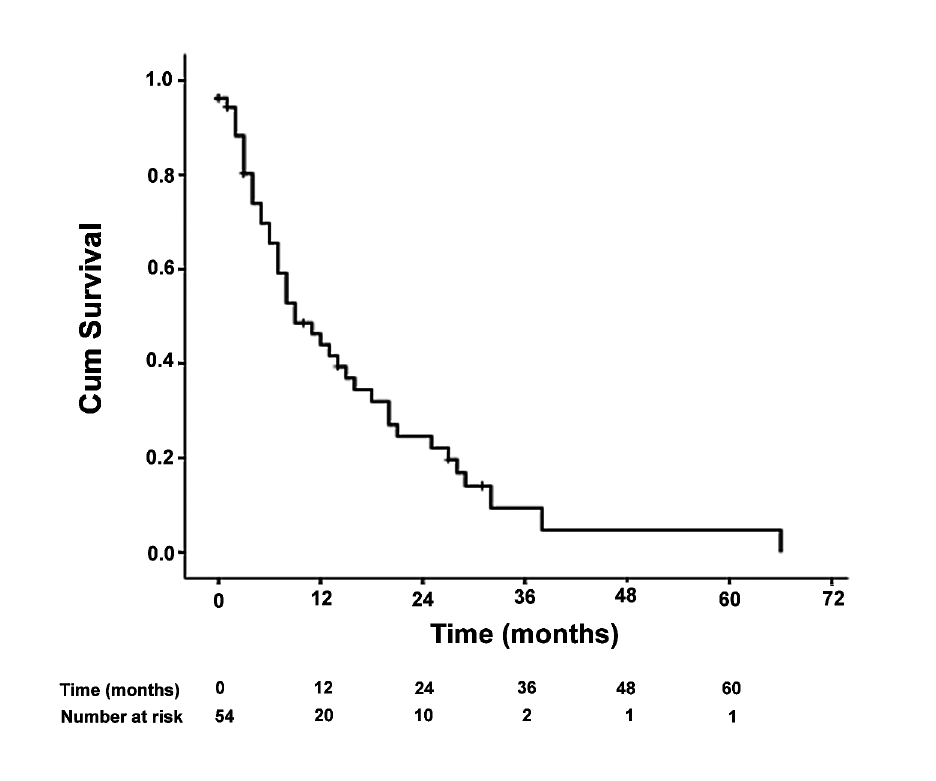
Figure 1 – Progression free survival from complete androgen